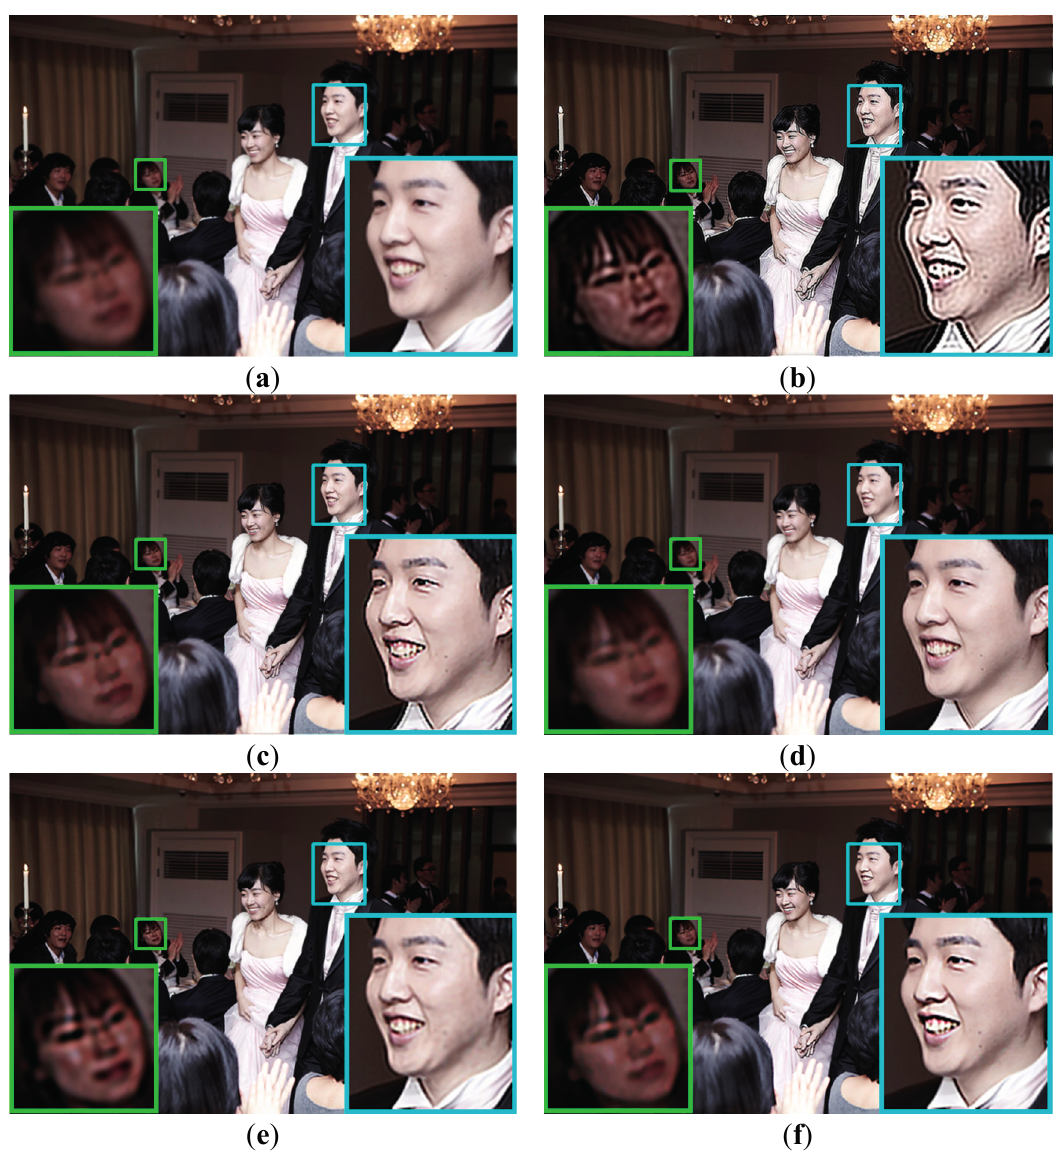
Figure 13. Comparison of different restoration algorithms using another real image; ( a ) the input image; ( b ) the restored image by the Dong’s method [24]; ( c ) the restored image by the Yang’s method [25]; ( d ) the restored image by the Xu’s method [12]; ( e ) the restored image by the Shen’s method [14]; and ( f ) the restored image by the proposed